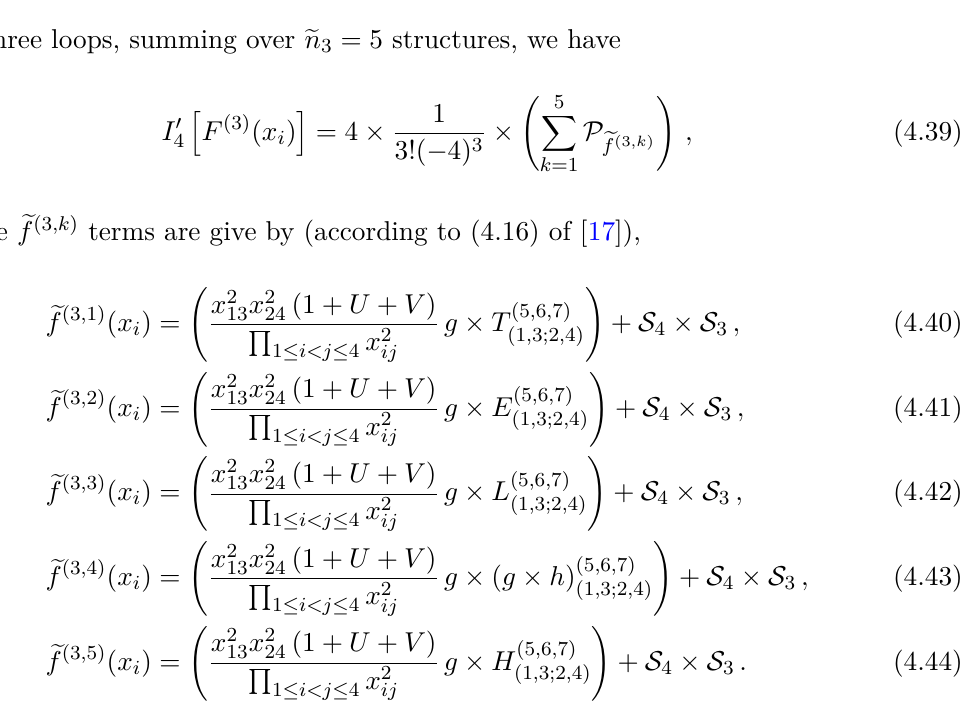
Figure 6. Here we draw some examples of e f -graphs, e f (3 , 5) three-loop computation. Once again, they are all non-planar